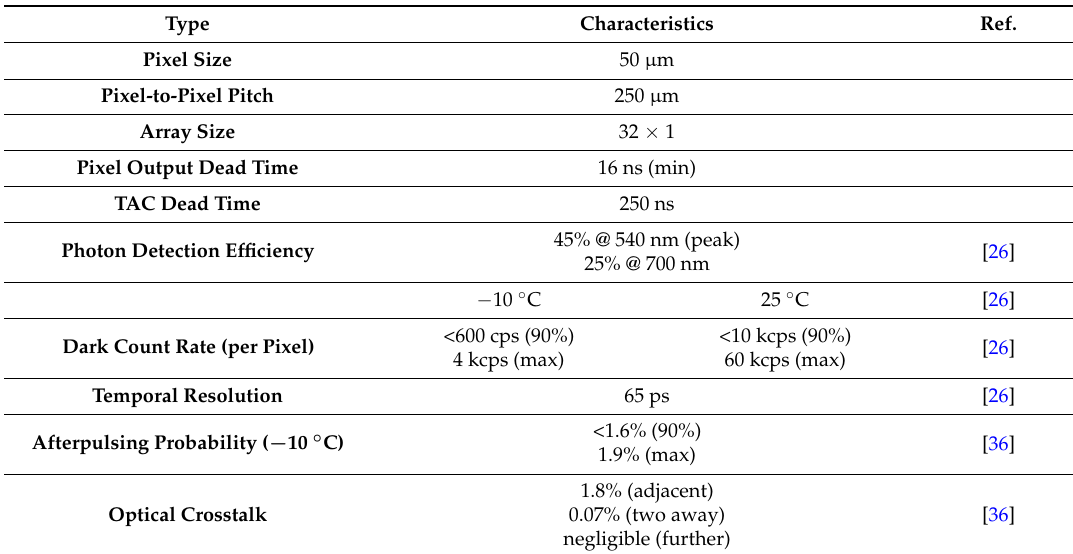
Table 1. Characteristics of the 32-channel SPAD